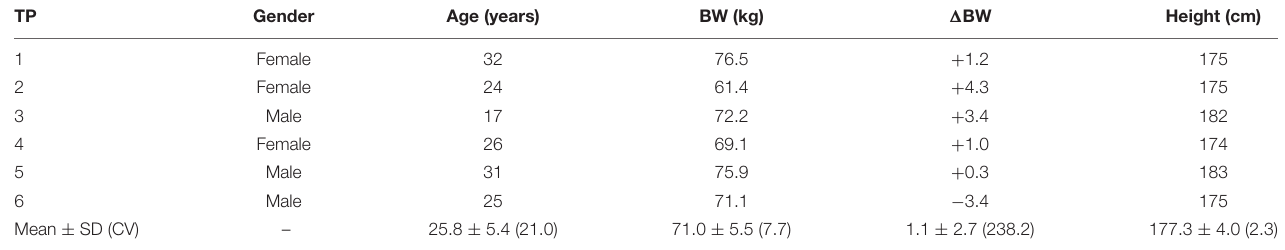
TABLE 1 | Subject characteristics at February